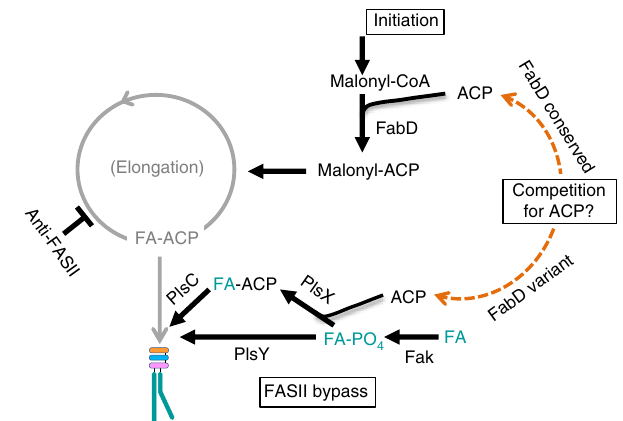
Figure 8 | Model of FASII bypass by S. aureus fabD 196 variants based on competition for ACP. A role for FabD in ACP balance and as a determining factor of FASII bypass is proposed. Indicated pathways and regulatory functions are as previously identified 43,67 . In grey, the inhibited FASII elongation pathway. FASII initiation enzyme FabD uses ACP and malonyl- CoA to synthesize malonyl-ACP 50 . In FASII inhibitory conditions, PlsX would compete for ACP pools to convert exogenous fatty acids (turquoise) into phospholipids. Less efficient activity of FabD 196 variants (Fig. 7) would leave ACP available for the PlsX reaction in the indicated direction (PlsX is a potentially reversible enzyme 43 ), as indicated by orange dashed arrow. Fak- PlsY and Fak-PlsX-PlsC as proposed here, mediate acyl group joining respectively to positions 1 and 2 of the glycerol-3-phosphate (G3P) backbone 31,43 . FA, fatty acid; FA-ACP, acyl-ACP; FA-PO 4 ,